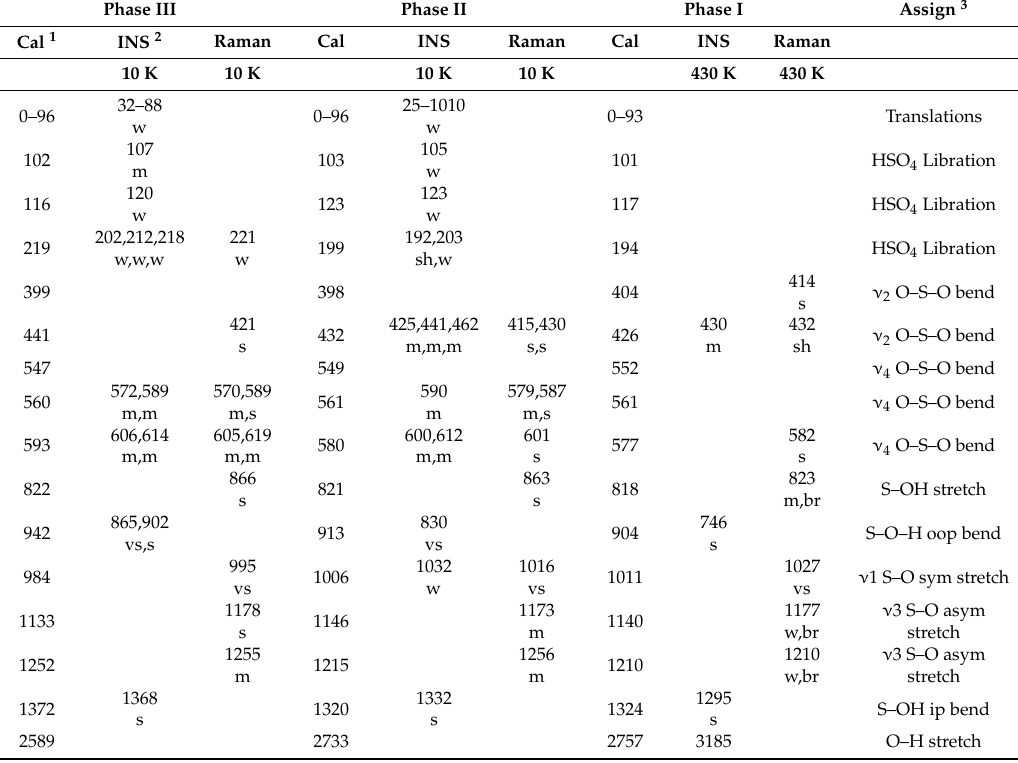
Table 1. Observed and calculated 1 transition energies (cm − 1 ) with assignments for CsHSO 4 in phases III, II and I.